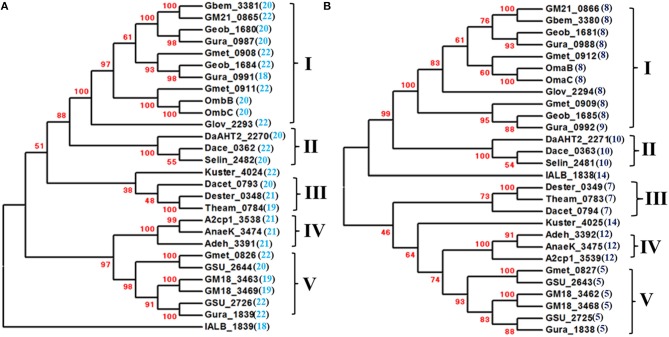
Phylogenetic analyses of the Pcc porin-like outer-membrane proteins (A) and periplasmic c-type cytochromes (B). The phylogenetic trees were constructed with MEGA6 and confidence levels are indicated in the major nodes by the bootstrap values (%) in red. The numbers in the parenthesis next to the locus tags are the numbers of their predicted trans-outer membrane motifs of the porin-like outer-membrane proteins (A) and heme-binding motifs of the periplasmic c-type cytochromes (B). The phylogenetic groups of the Pcc porin-like outer-membrane proteins (A) and periplasmic c-type cytochromes (B) are indicated by Roman numerals. The trees are not drawn to scale.